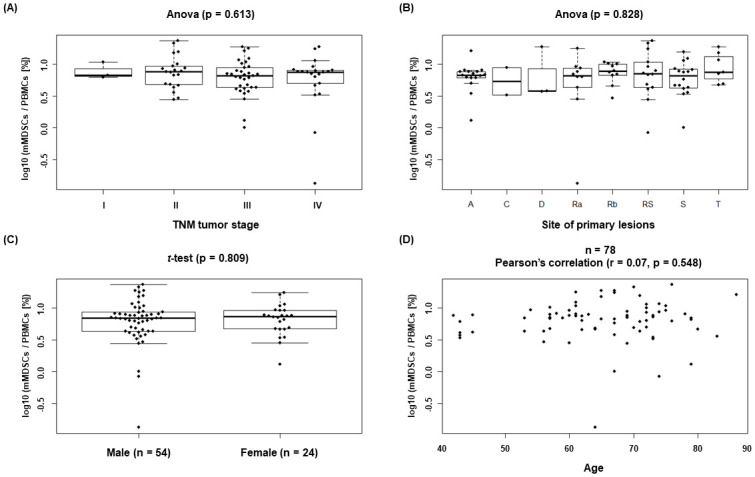
Correlation analysis between mMDSC proportion and stage/demographics in CRC patients.Correlation between mMDSC proportion and (A) TNM stage. (B) The site of the primary lesion. (C) Sex, and (D) Age. mMDSC proportion (% of PBMCs) was transformed by log 10. Data were analyzed by one-way analysis of variance (ANOVA).